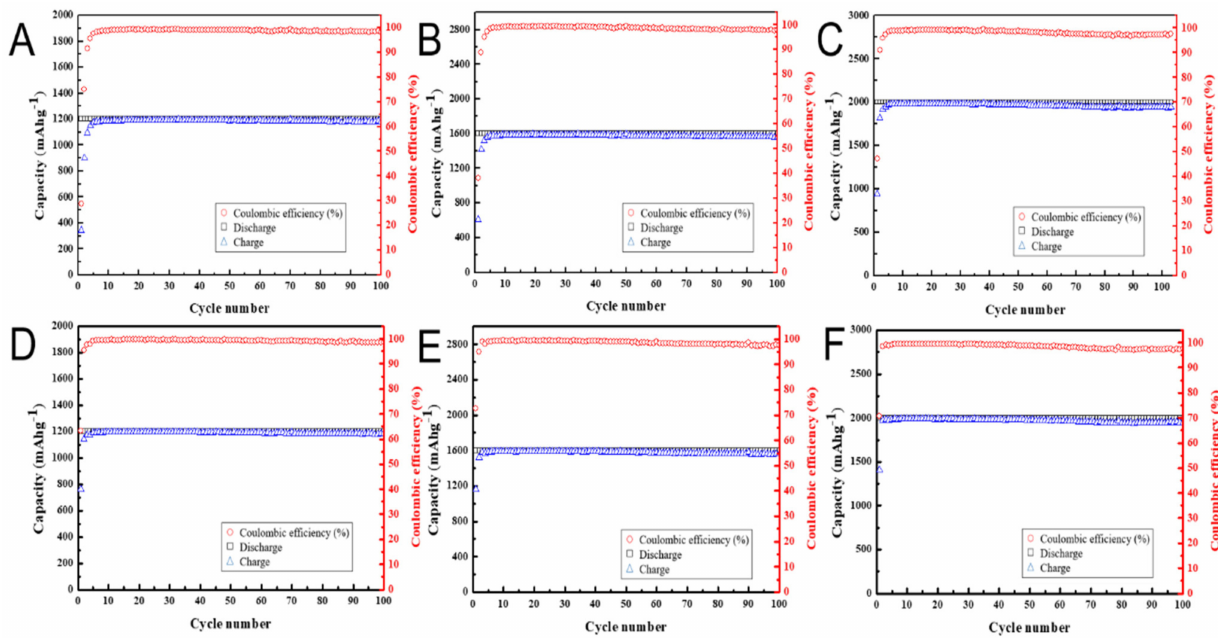
Figure 14. Cycling performance of nanocarbon-coated (650 ◦ C) silicon-based anode ( A – C ) without and ( D – F ) with Super-P conductivity enhancing agent. The cycling performance is compared at fixed discharging and charging levels of ( A , D ) 1200 mAh/g, ( B , E ) 1600 mAh/g, and ( C , F ) 2000 mAh/g. The discharging/charging rate is 0.01 C for the first three cycles and 0.1 C for remaining